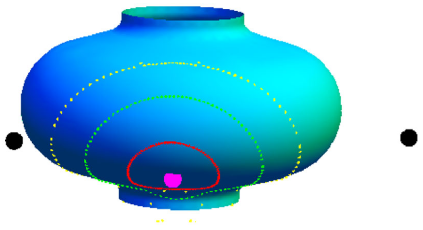
FIG. 15. Limit of the quench spot at different times (each time corresponds to a color). The large pink point is the quench position and the large dark points represent